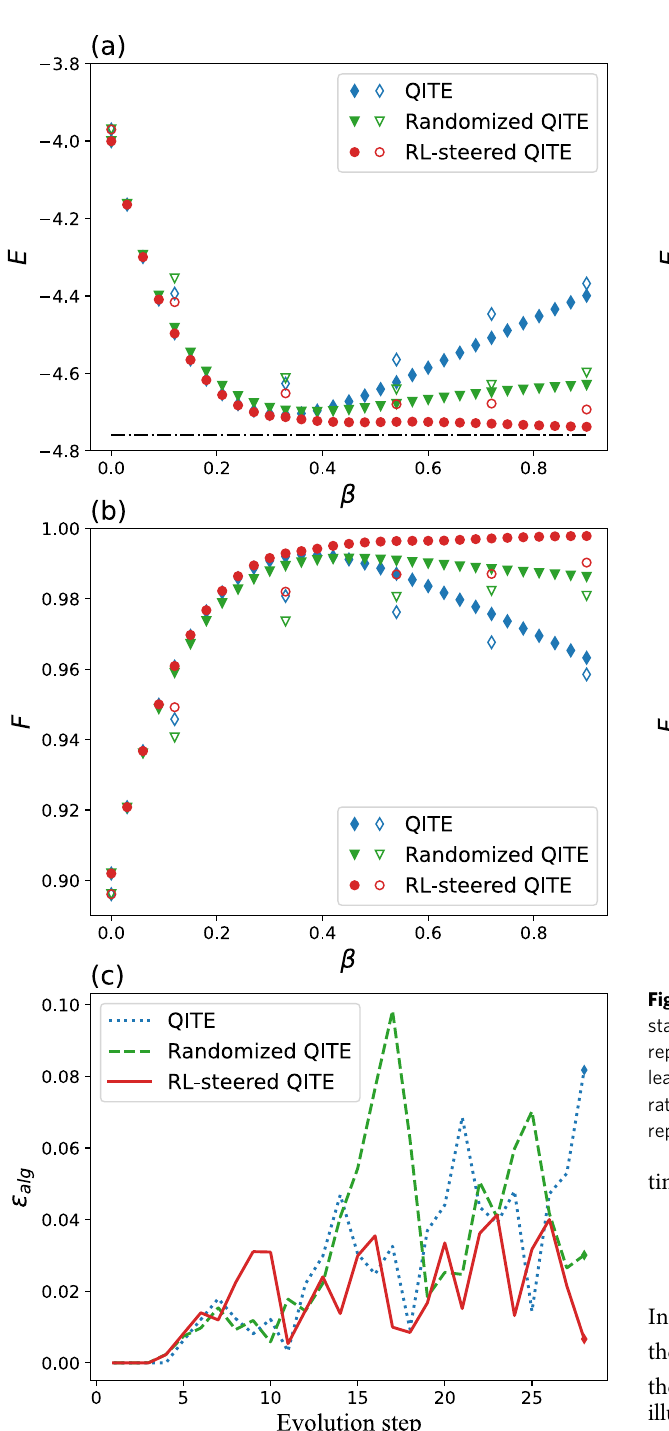
Fig. 2 Different QITE schemes for the transverse- fi eld Ising model. Filled markers represent the numerical data; un fi lled markers represent the experimental data. The experimental errors were mitigated by virtual distillation. Blue diamonds/dotted lines represent the standard quantum imaginary time evolution (QITE); green triangles/dashed lines represent the randomized QITE; red circles/lines represent the reinforcement learning (RL)-steered QITE. a Energy versus β , the black dashed line represents the ground state energy. b Fidelity versus β . c Algorithmic errors during the evolution.